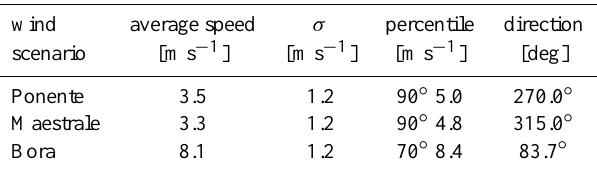
Table 1. Wind statistics from data recorded from 12 to 16 Septem- ber 2011.